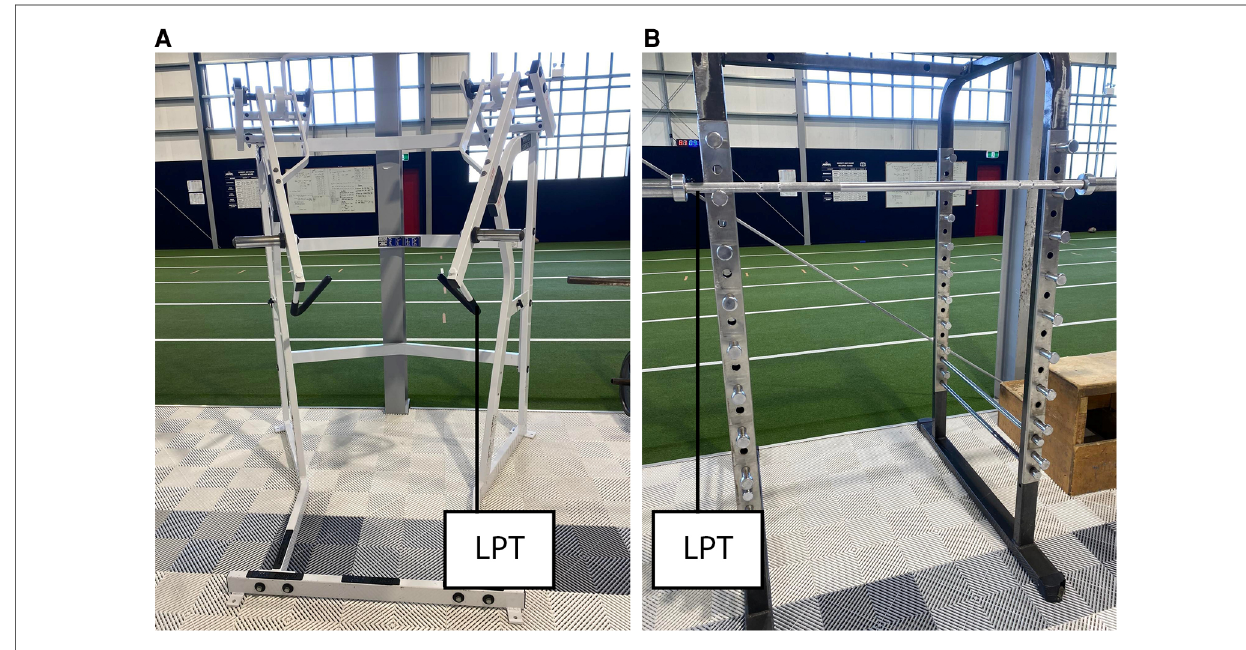
FIGURE 1 Testing set up for: ( A ) Double-arm jammer push-press and ( B ) Barbell box